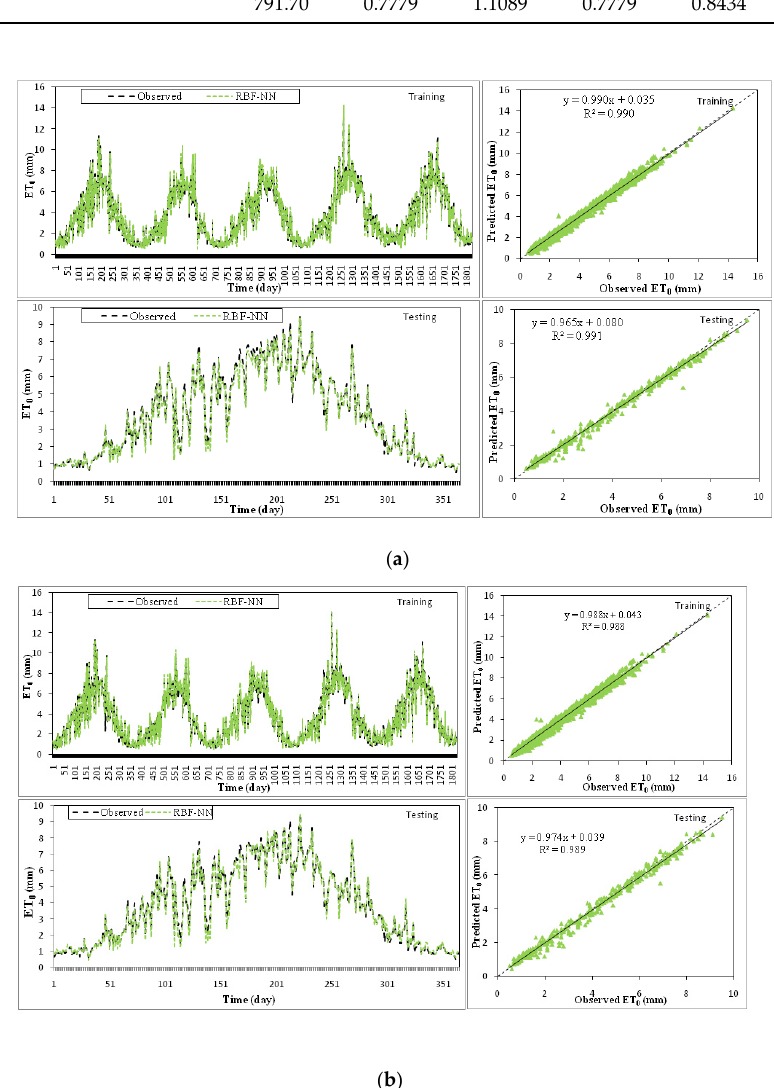
Figure 6. Performance of the best performing ( a ) RBFNN M5 and ( b ) RBFNN M11 models for both training and testing stages.